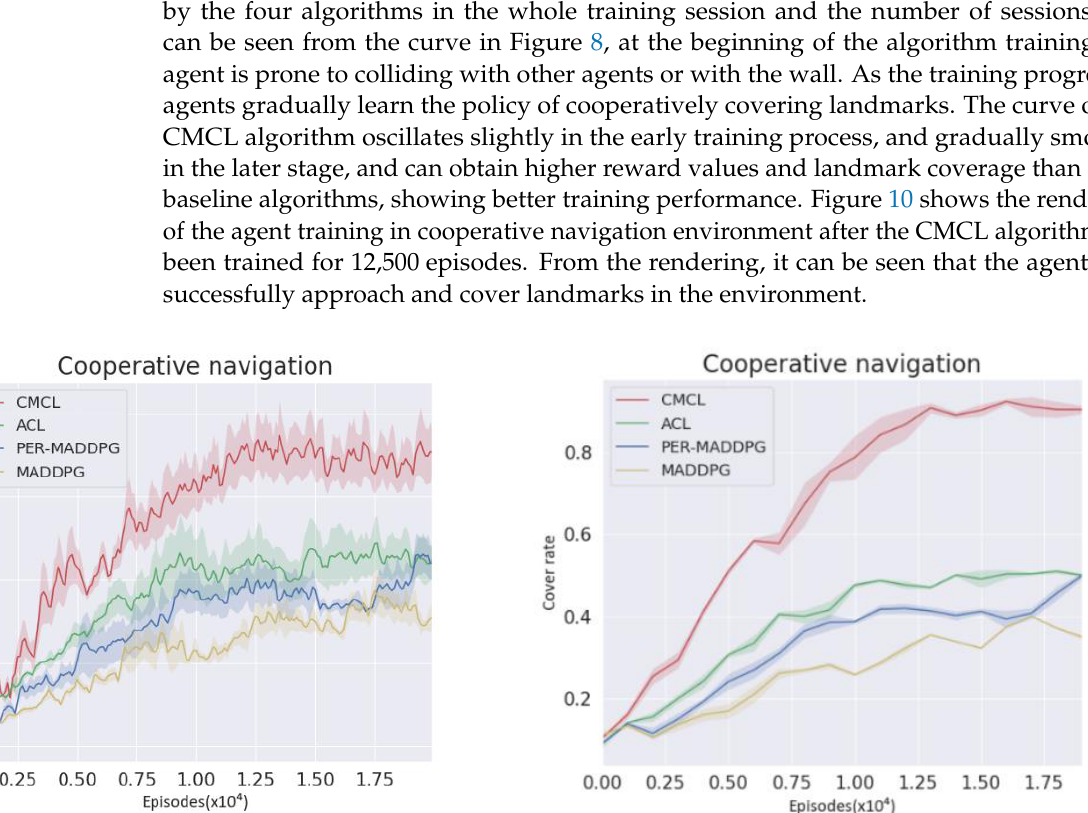
Figure 8. Representation diagram of agents in cooperative environment. ( a ) Average reward in cooperative environment; ( b ) landmark cover rate in cooperative environment.